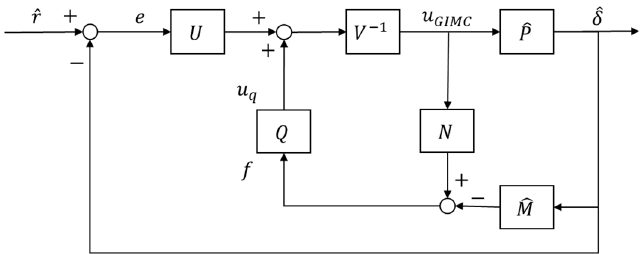
Figure 12. The standard GIMC control structure for the suspension system.